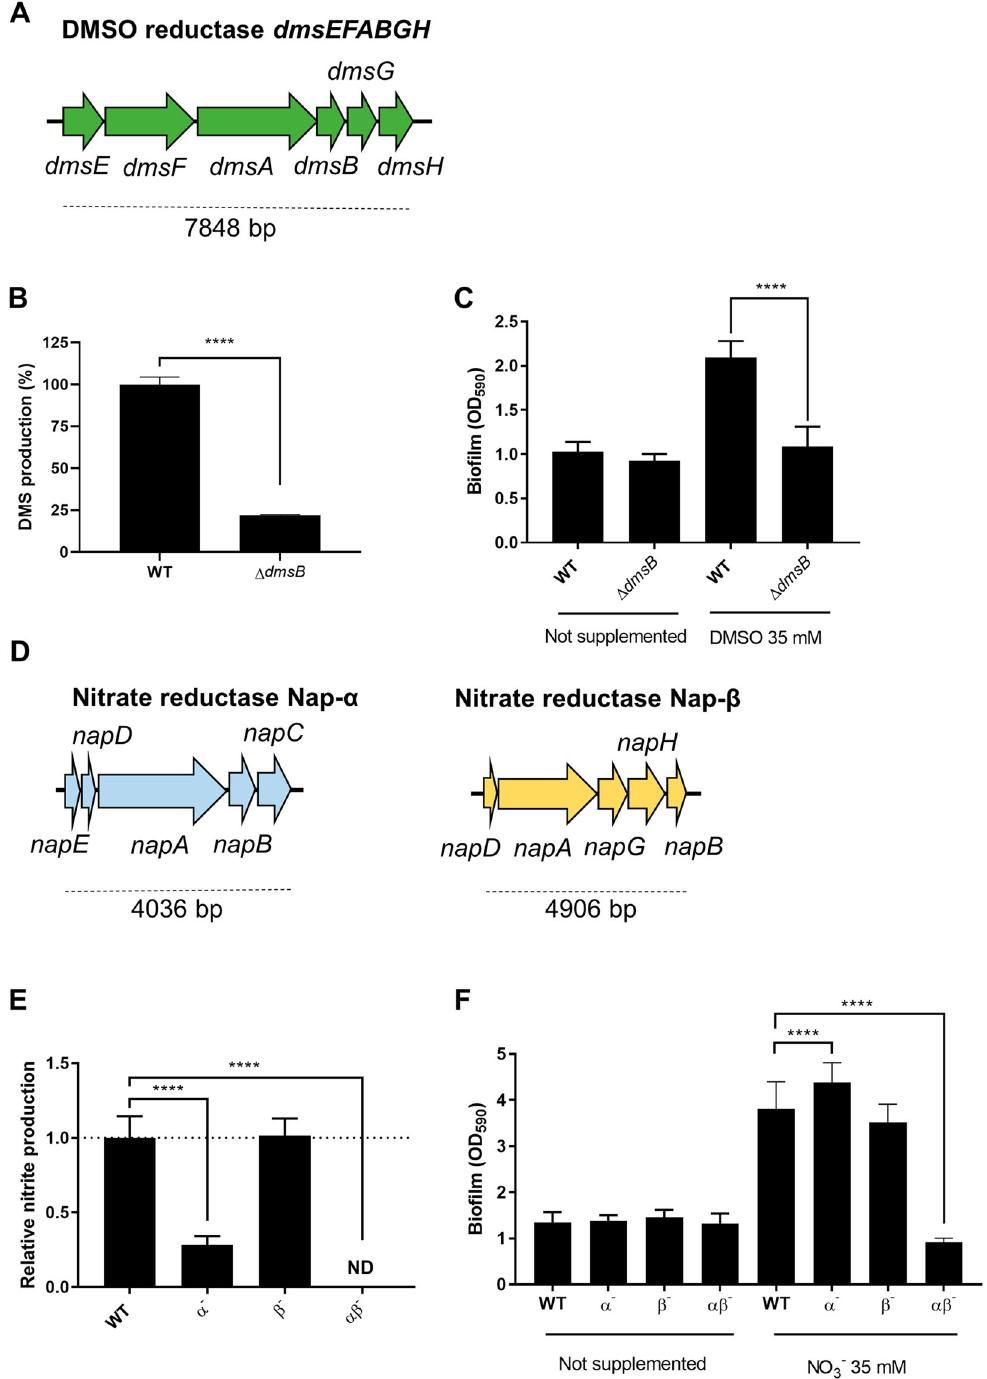
Fig. 4 Disruption of terminal reductase activity abrogates the bio fi lm response. a Schematic of the DMSO reductase encoding dmsEFABGH operon of Shewanella algae . b DMSO reduction of the WT strain and dmsB in-frame deletion mutant (**** P < 0.0001, two-tailed unpaired t test) as evidenced by measuring DMS production of three independent cultures supplemented with 35 mM DMSO. c Bio fi lm formation of S. algae CECT 5071 WT and Δ dmsB in the absence or presence of DMSO (**** P < 0.0001, two-tailed unpaired t test). Data represent the average and SD of three biological replicates with seven technical replicates each. d Schematic of the periplasmic nitrate reductase NAP- α encoding operon napEDABC and NAP- β encoding operon napDAGHB of S. algae . e Nitrate reduction by the single mutants Δ napABC ( α − ) and Δ napA ( β − ), and the double mutant Δ napABC Δ napA ( αβ − ) as determined by nitrite accumulation with respect to the WT strain upon supplementation with 35 mM nitrate (**** P < 0.0001; one-way ANOVA followed by Dunnett ’ s post-hoc test; ND no nitrite production detected). Data represent the average and SD of three biological replicates with four technical replicates per sample. f Bio fi lm formation of S. algae CECT 5071 WT and nitrate reduction mutants in the absence or presence of sodium nitrate (**** P < 0.0001, one-way ANOVA followed by Dunnett ’ s post-hoc